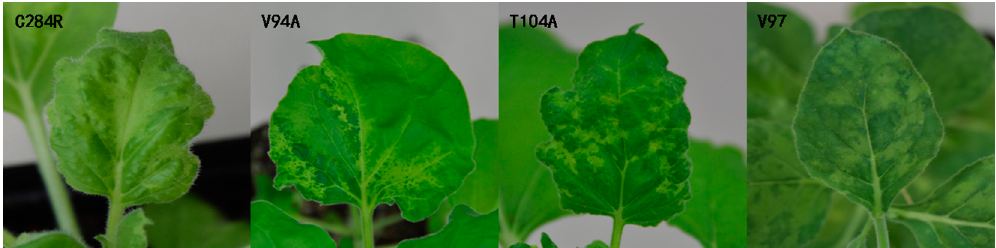
Figure 1. Symptoms of N. benthamiana inoculated with WT, V94A, T104A and V97 mutants at 10, 14, 21, and 40 days post-inoculation (dpi). Table 2. Systemic infection of N. benthamiana with CGMMV mutants and detection of upper non-inoculated leaves of N. benthamiana by double antibody sandwich enzyme-linked immunosorbent assay (DAS-ELISA).